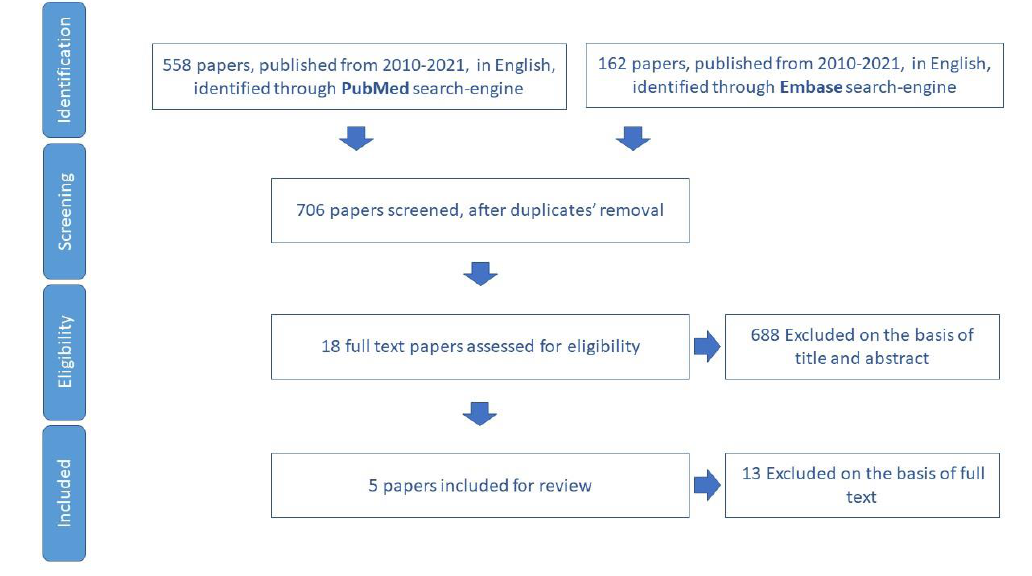
Figure 9. Process of study selection for social support domain.